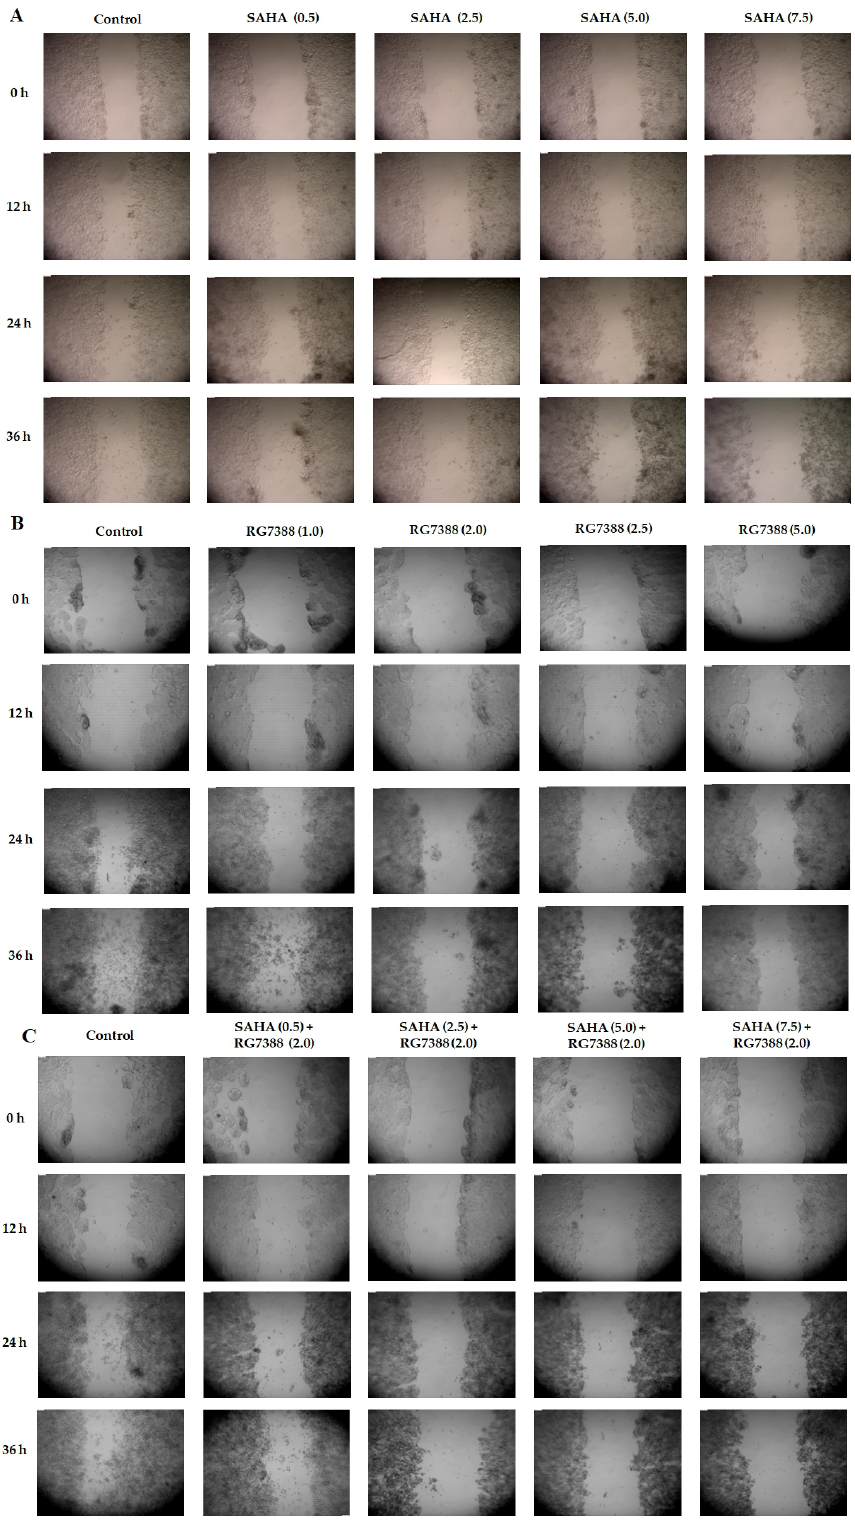
Figure 4. Inhibitory effects of SAHA and RG7388, in individual or combinations treatments, on MCF-7 cell migration during scratch assays. Representative images of MCF-7 cells captured at 0, 12, 24, and 36 h of treatment with different drugs. ( A ) Cells treated with 0.5, 2.5, 5.0, and 7.5 µ M of SAHA. ( B ) Cells treated with 1.0, 2.0, 2.5, and 5.0 µ M of RG7388. ( C ) Cells treated with SAHA and RG7388 (2.0 µ M) in